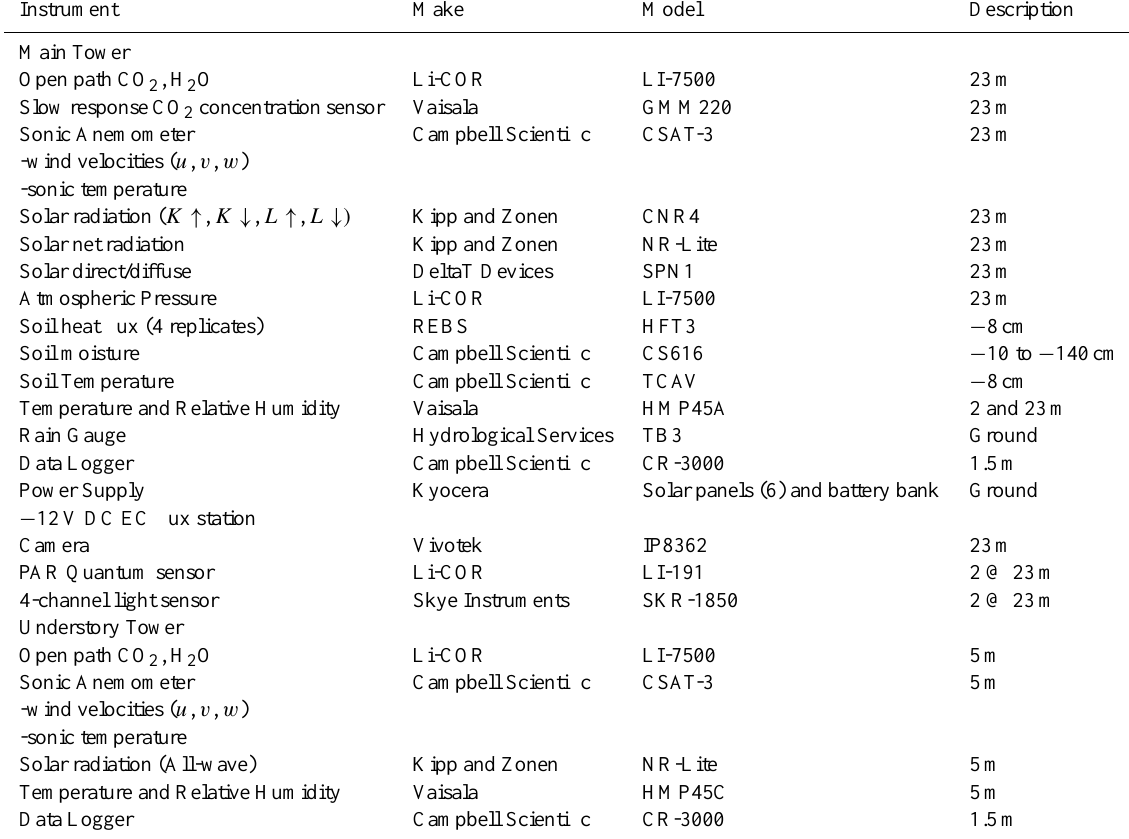
Table 1. List of instrumentation installed on the ecosystem and understory flux towers at the Howard Springs OzFlux site; where “ u ” is the along wind component, “ v ” is the across wind component and “ w ” is the vertical wind component of wind velocity in 3-dimensional space, K ↓ and L ↓ refer to incoming and K ↑ and L ↑ refer to outgoing shortwave and longwave radiation, respectively.